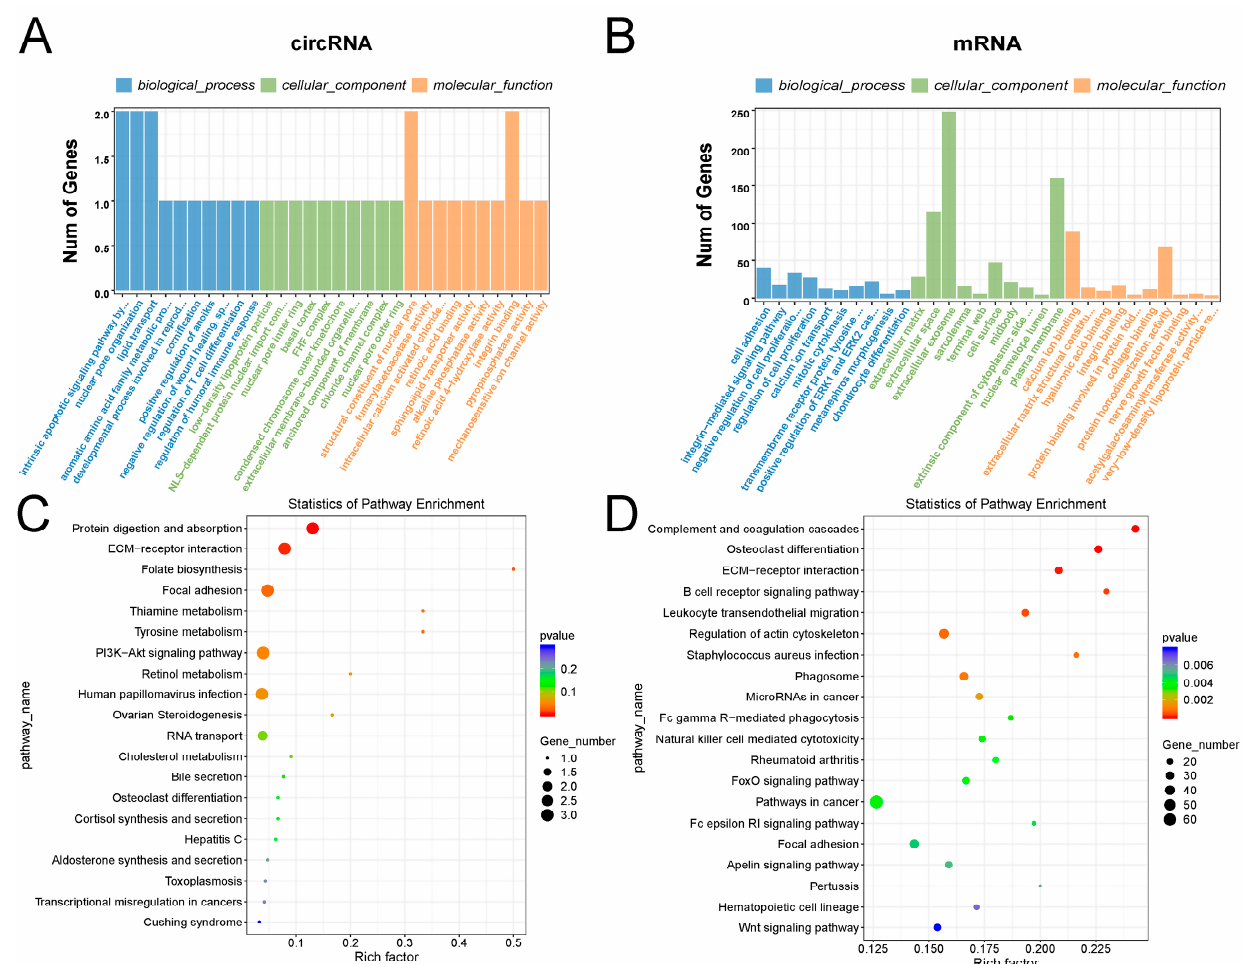
Figure 3. GO and KEGG analysis of circRNA, miRNA, and mRNA. ( A , B ) Top 10 GO terms for differentially expressed circRNA and mRNAs in biological processes, cellular components, and molecular functions. ( C , D ) KEGG analysis of differentially expressed circRNA and mRNAs. Only the top 10 enriched KEGG pathways are shown in the figure.